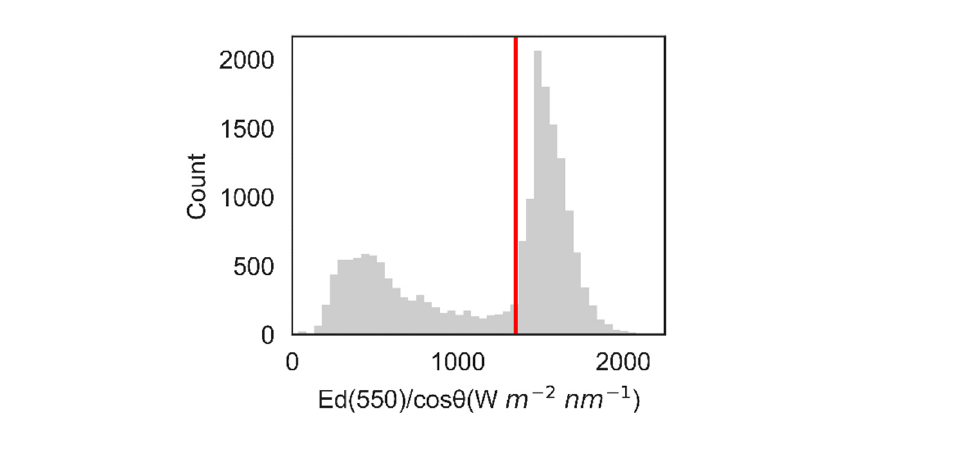
Figure 5. Histogram of cosine-normalized irradiance at 55 nm for the 18-day experiment. The red vertical line at 1350 mWm − 2 nm − 1 shows the threshold used to distinguish clear-sky and cloudy